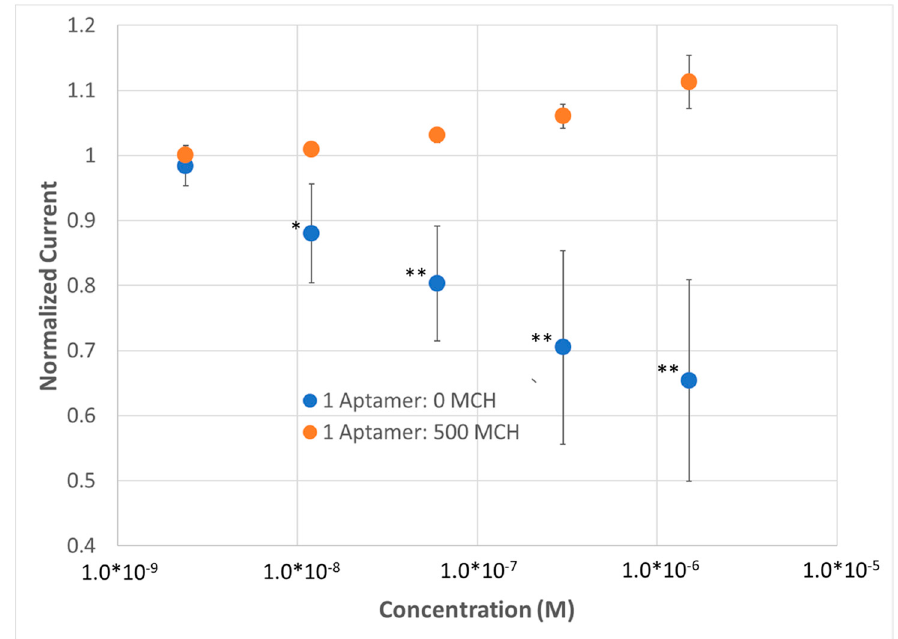
Figure 4. Demonstration of lysozyme aptasensor (n = 5) using square wave voltammetry (SWV) with a dense SAM versus a dilute SAM. p values < 0.05 (*), 0.01 (**) and 0.001 (***) determined using a two-tail t-test.